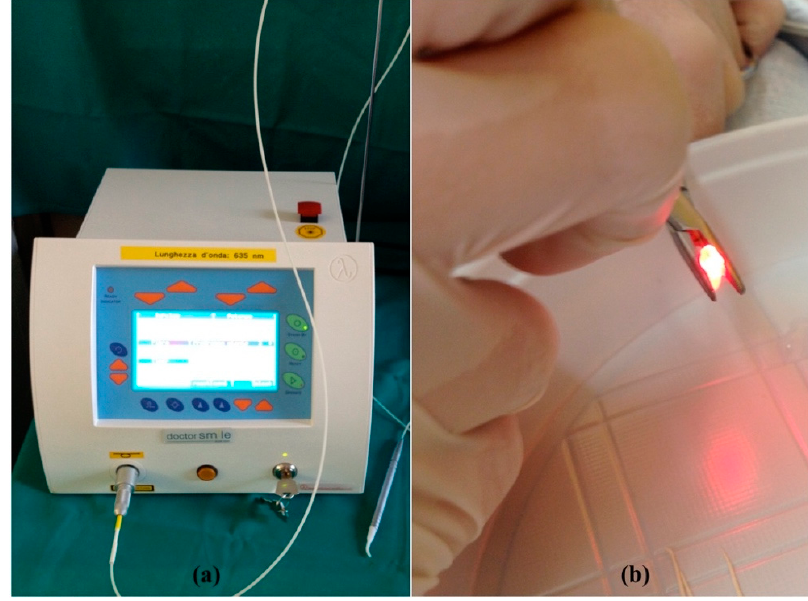
Figure 2. ( a ) The diode laser with a wavelength of 635 nm (LAMBDA SpA, Brendola (Vi), Italy); ( b ) irradiation of a root canal.